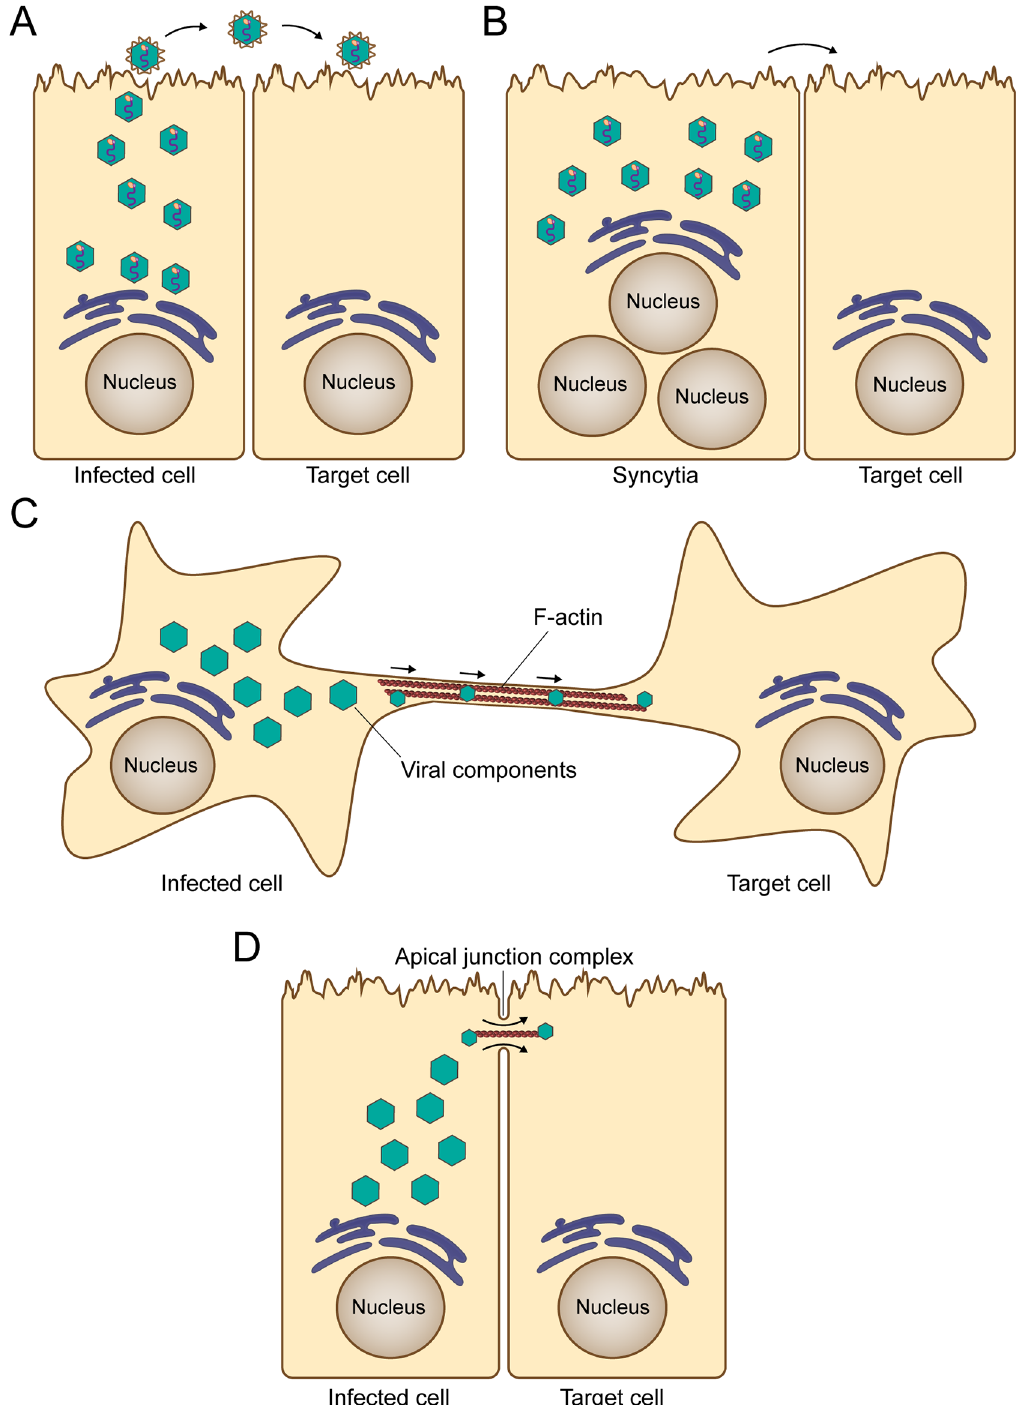
Fig 1. Classical and new mechanisms of spread by respiratory viruses. A) The canonical route of virus spread involves the release of completely assembled viral particles to the extracellular environment for subsequent infection of target cells. B) The formation of syncytia involves the fusion of infected cells with adjacent target cells and remains an important mechanism of direct cell-to-cell spread of viral components. This mechanism of spread has been reported for influenza, HMPV, PIVs, RSV, and MeV, among others. C) Intercellular extensions connect two distant cells to facilitate transport of viral components, and their formation requires F-actin polymerization. This mechanism of viral spread has been reported in immortalized lung